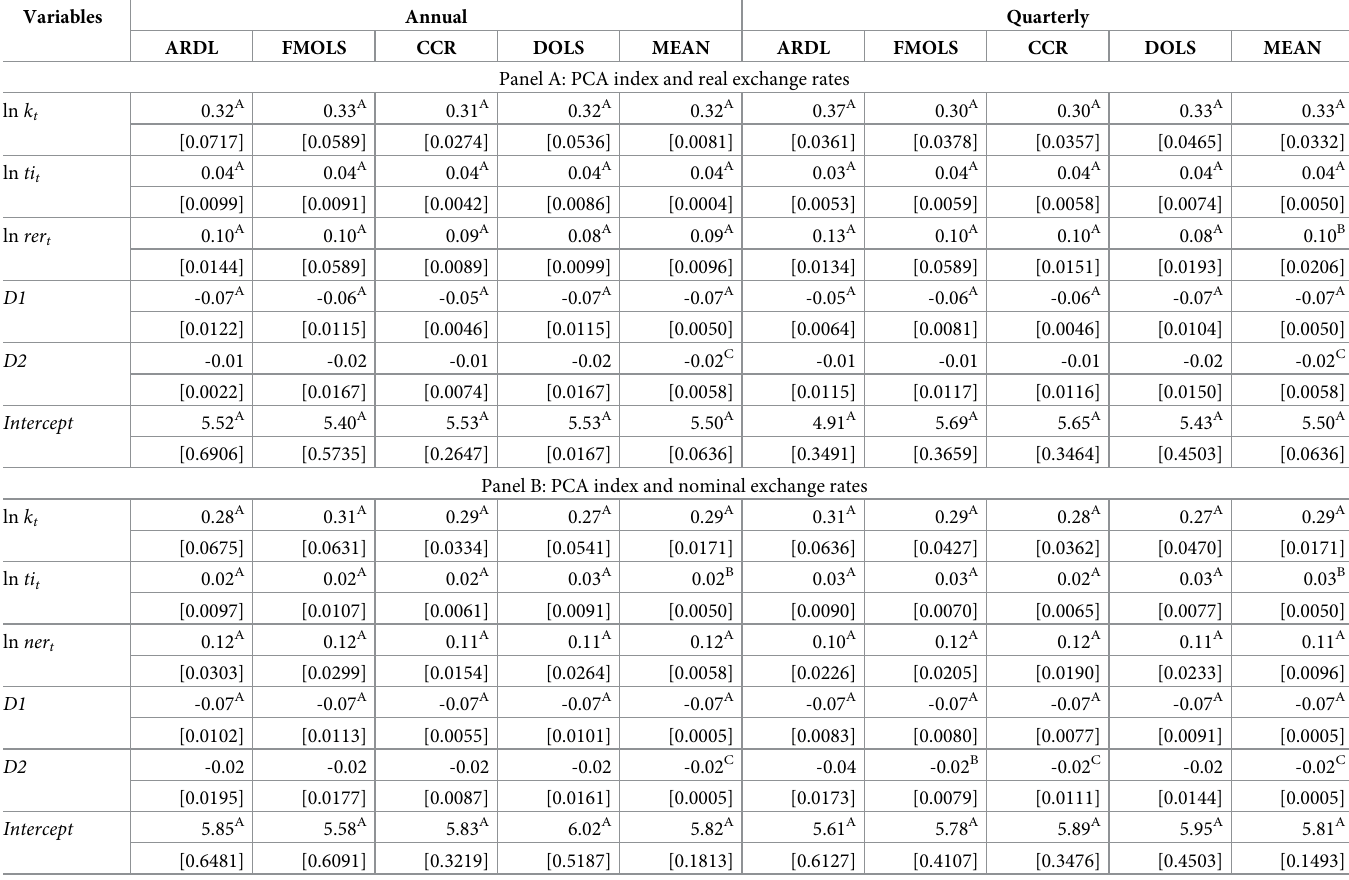
Table 9. PCA tourism development index